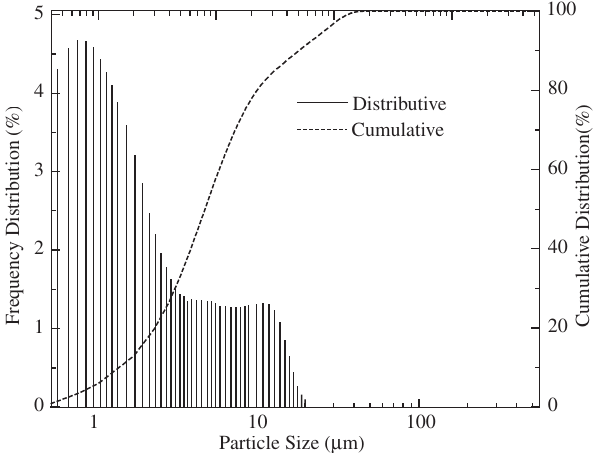
Figure 2. Particle size distribution of alumina.